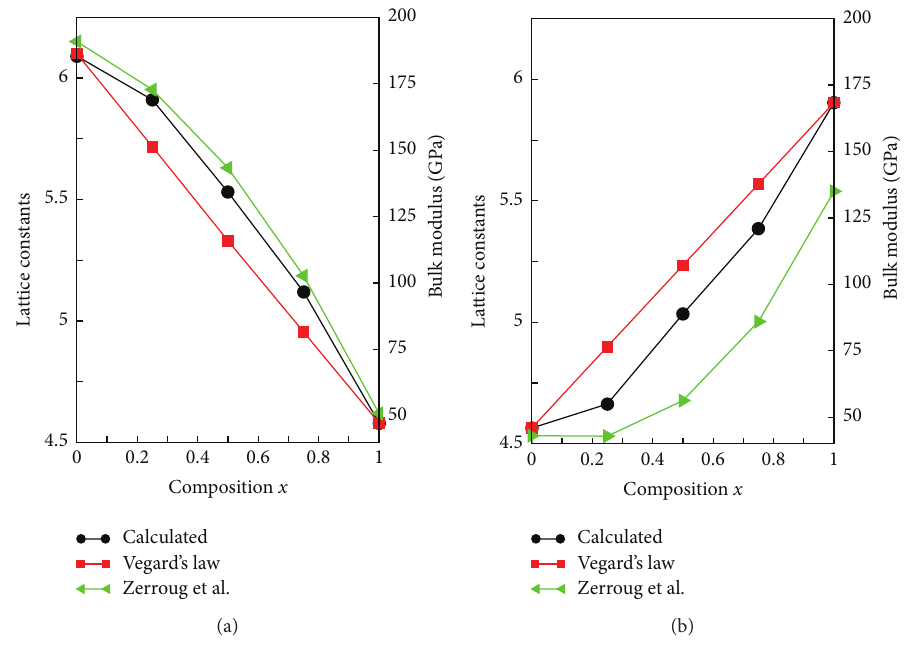
Figure 1: Variation of (a) lattice constant and (b) bulk modulus of ZnOTe with concentration 𝑥